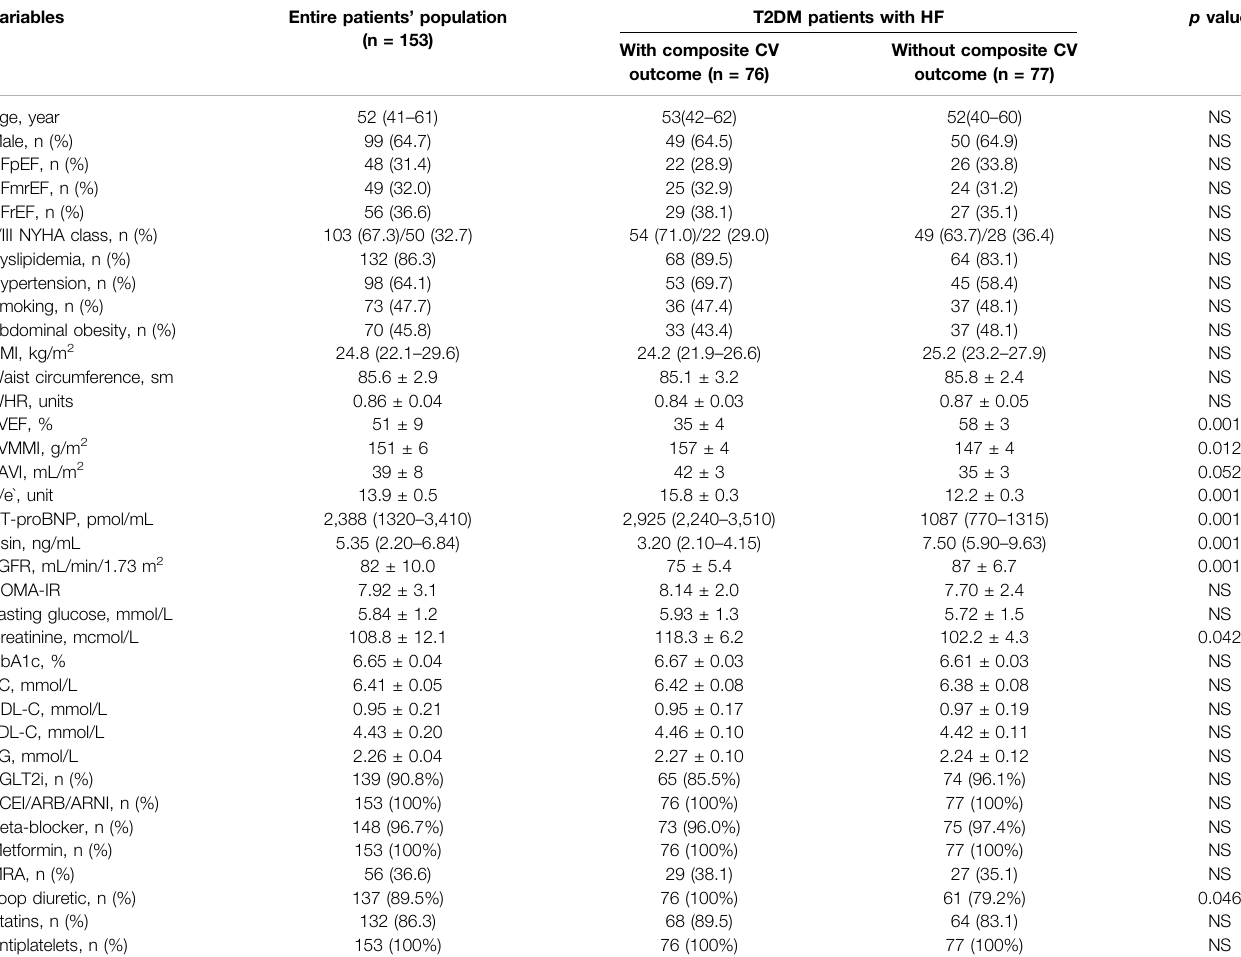
TABLE 1 | Baseline demographic, clinical and hemodynamic characteristics of study population. Variables Entire patients ’ population (n =